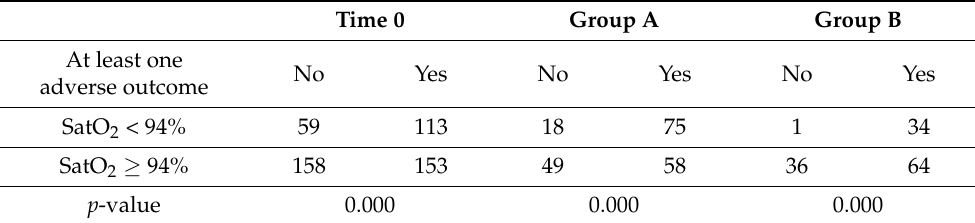
Table 2. Number of patients based on SatO2 values at time 0, in Group A and Group B, divided into those with and without at least one adverse outcome. Time 0 Group A Group B